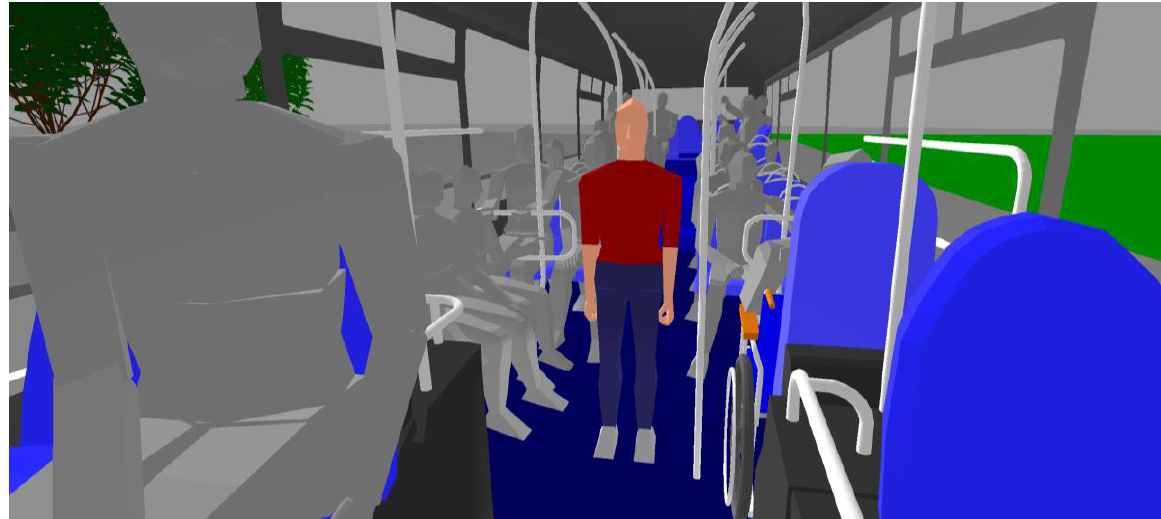
Figure 6. HADRIAN P13, UK Female digital human model within the bus.